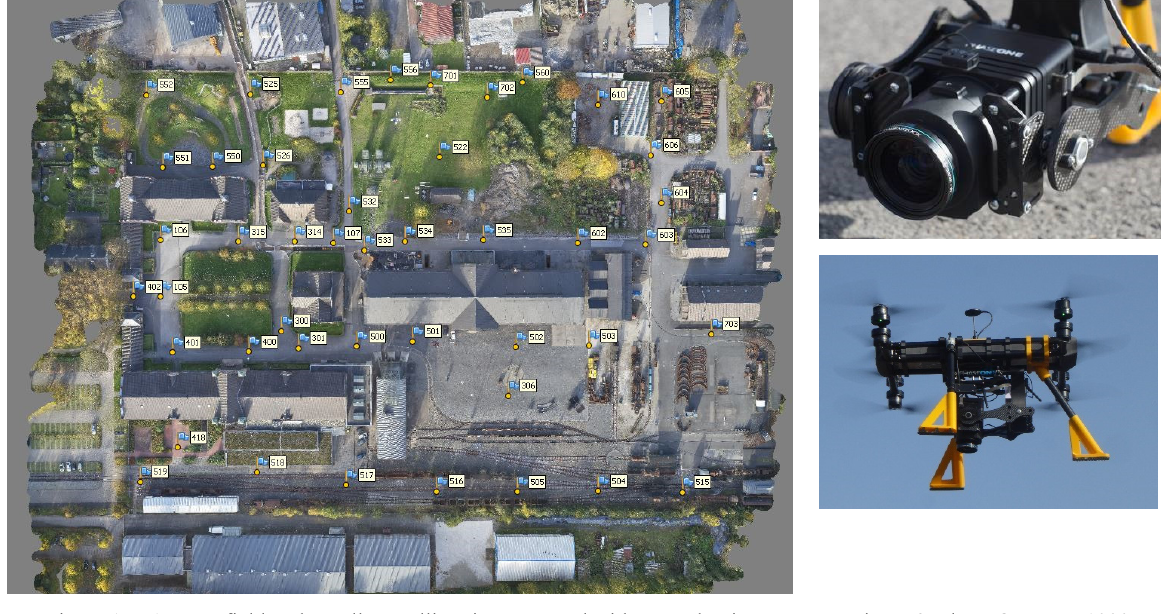
Figure 1. UAV test field at the Zollern colliery in Dortmund with control point distribution (used as check points ChP)